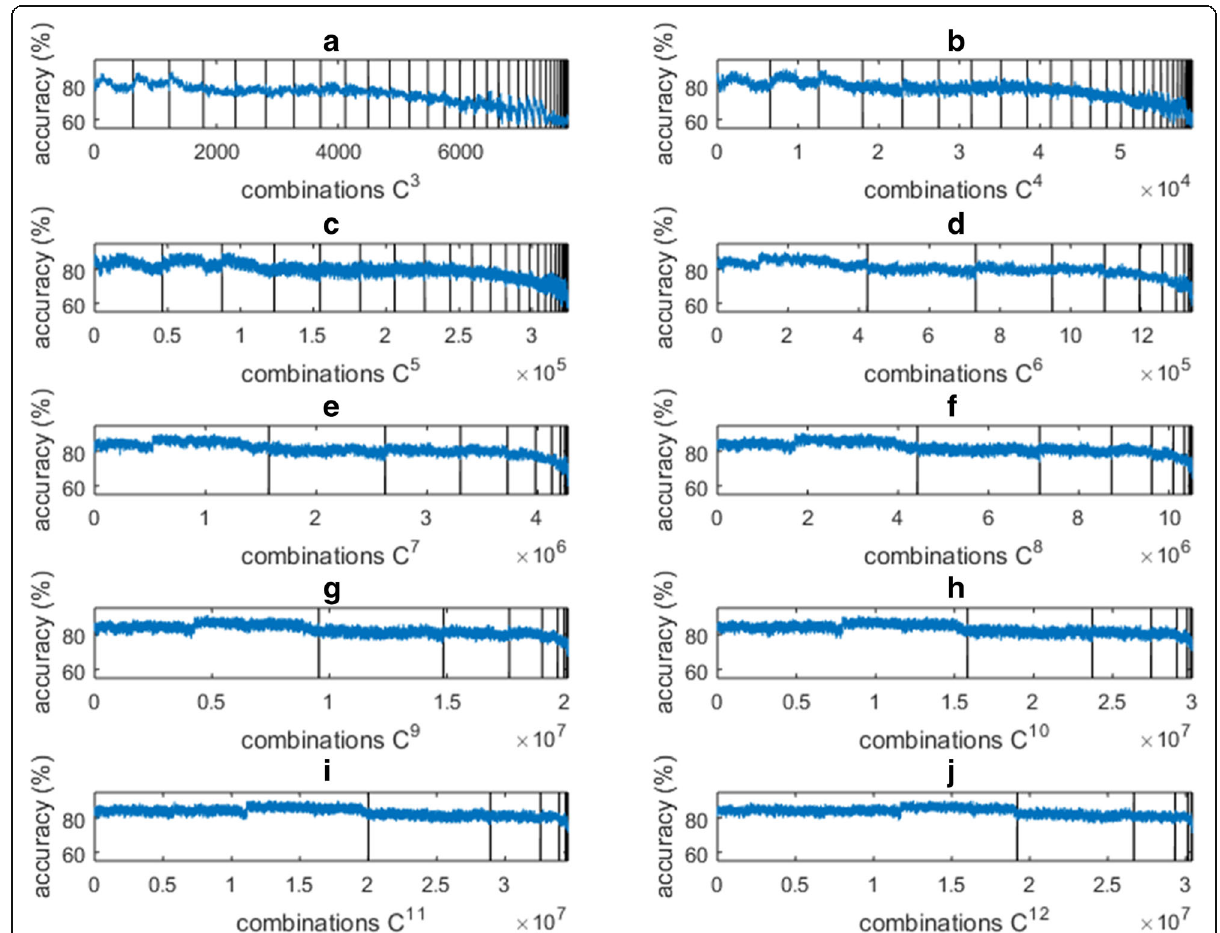
Fig. 8 Obtained accuracy results for N = 3 ( a ), N = 4 ( b ), N = 5 ( c ), N = 6 ( d ), N = 7 ( e ), N = 8 ( f ), N = 9 ( g ), N = 10 ( h ), N = 11 ( i ) and N = 12 ( j